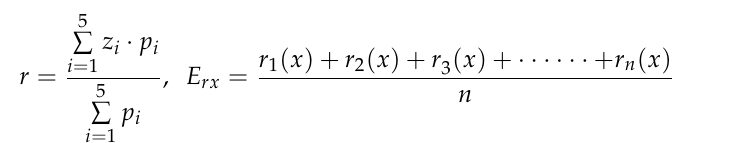
Figure 5. A C index standard cloud chart. Figure 6. Standard cloud chart of total target resilience. Figure 7. Cloud chart of overall target resilience evaluation level.